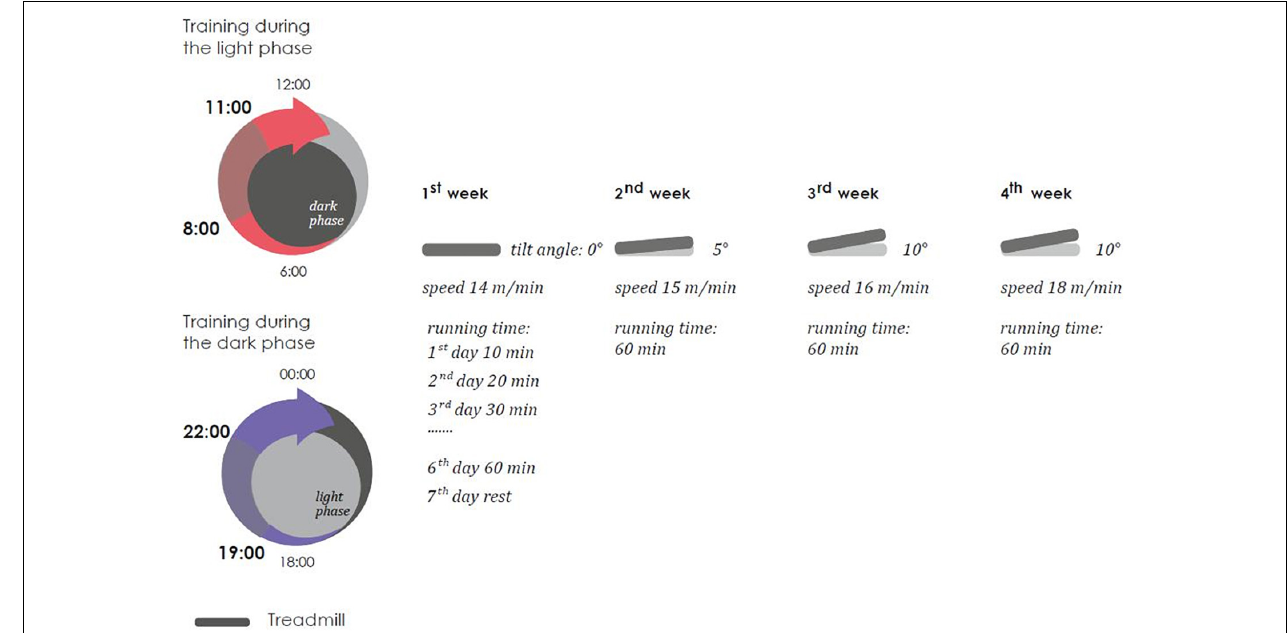
FIGURE 3 | Scheme of treadmill